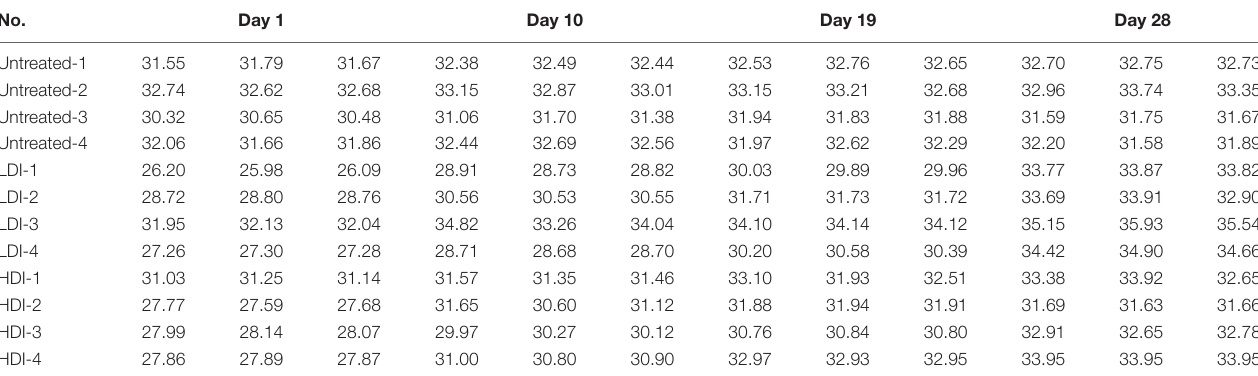
TABLE 2 | CT values of P72 in pigs treated with low-dose and high-dose interferons. No. Day 1 Day 10 Day 19 Day 28